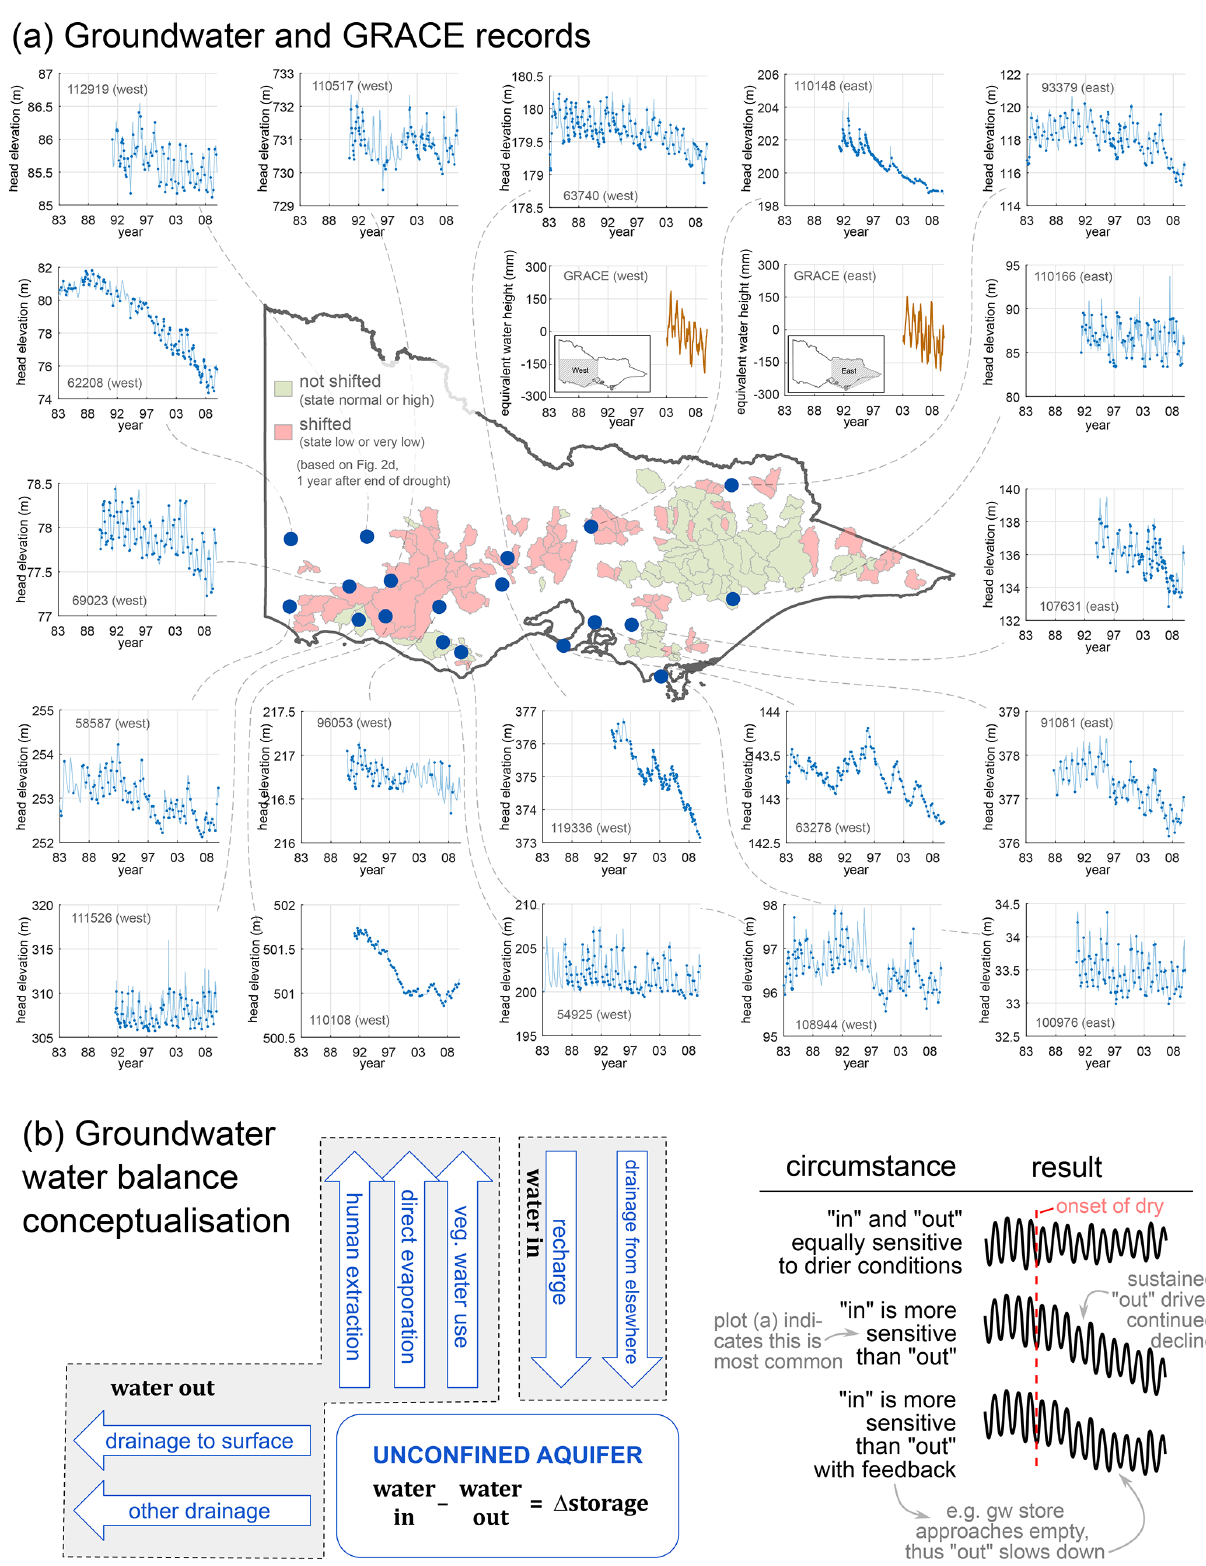
Figure 4. (a) Groundwater hydrographs for 19 bores and GRACE data in the state of Victoria, after Fowler et al. (2020a). (b) Water balance conceptualisation for unconfined aquifers in headwater